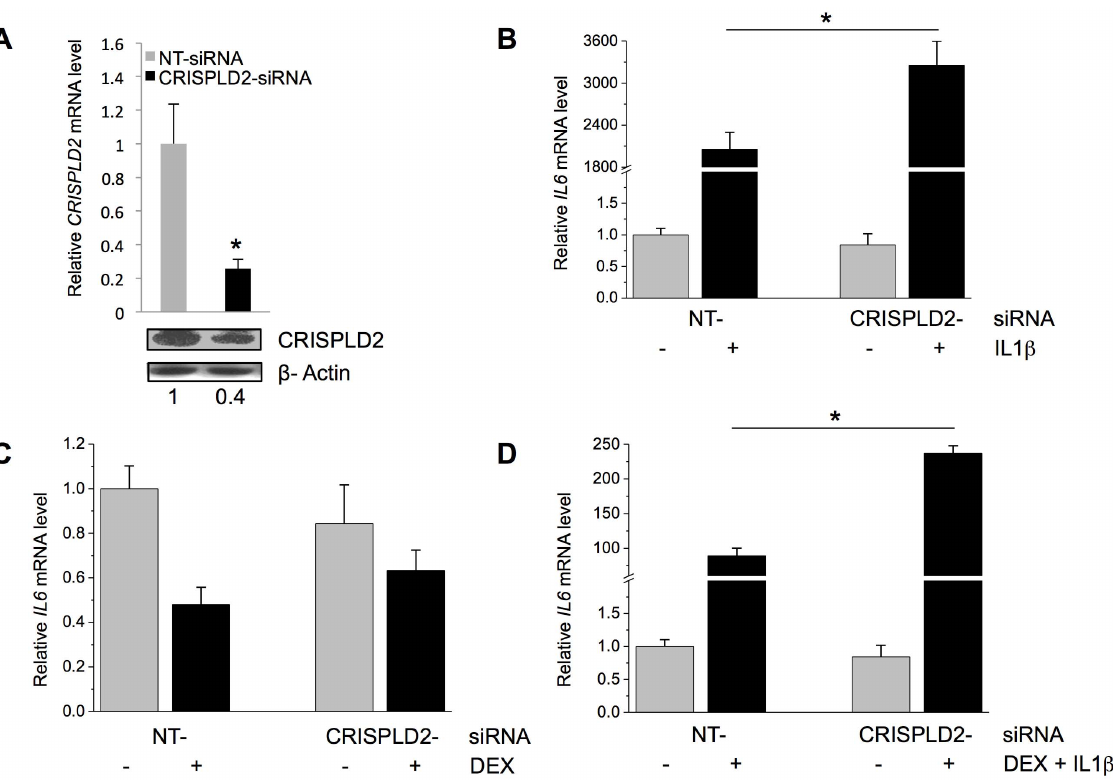
Figure 4. CRISPLD2 regulates the response to inflammatory cytokines. A ) Effect of CRISPLD2 -specific siRNA on CRISPLD2 mRNA and protein levels. ASM cells were transfected with CRISPLD2 -specific siRNA or non-targeting (NT) siRNA, and 72 h later, CRISPLD2 mRNA and protein levels were determined by qRT-PCR (levels normalized to those in control cells transfected with NT siRNA) and immuno-blotting, respectively. The effect of CRISPLD2 knockdown on IL1 b -induced cytokine expression was assessed by transfecting ASM cells with CRISPLD2 -specific or NT siRNA, and 72 h later, treating cells for 24 h with B ) 5 ng/mL IL1 b , C ) 100 nM DEX, or D ) 5 ng/mL IL1 b and 100 nM DEX. IL6 expression was determined by qRT-PCR. Normalized mRNA levels are shown. Experiments were performed in triplicate, and the error bars are SE values for three samples. * P , 0.05 ( t